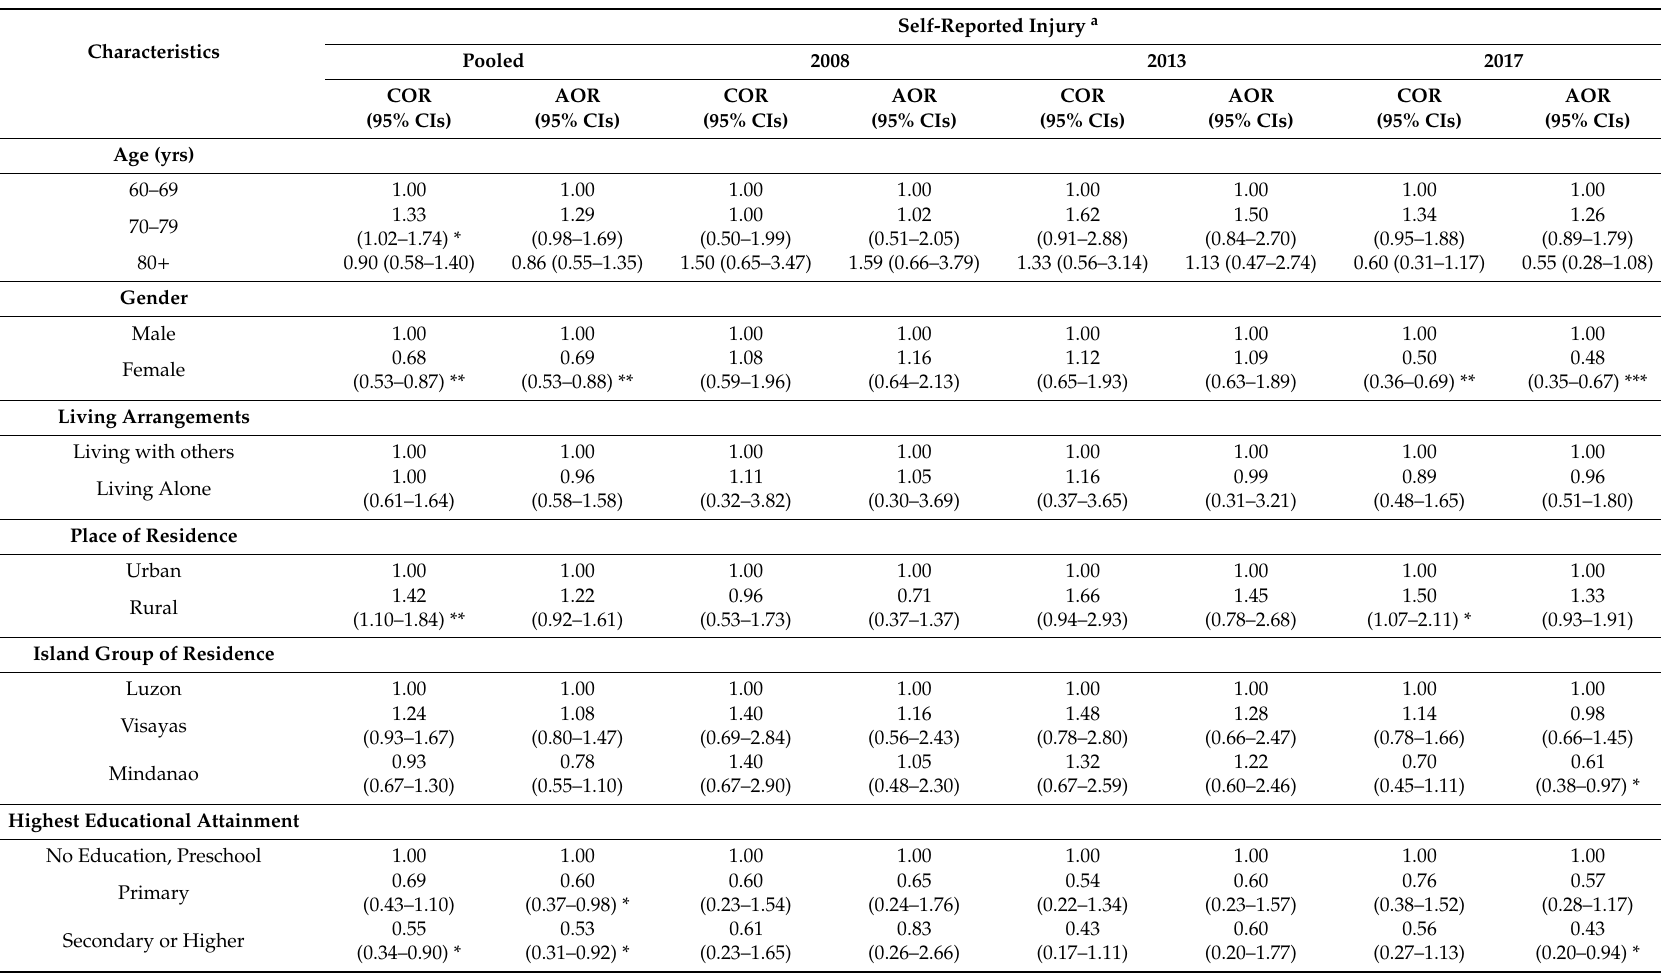
Odds ratios for association between socioeconomic, demographic, and health characteristics and self-reported injuries among older adults, Philippines,